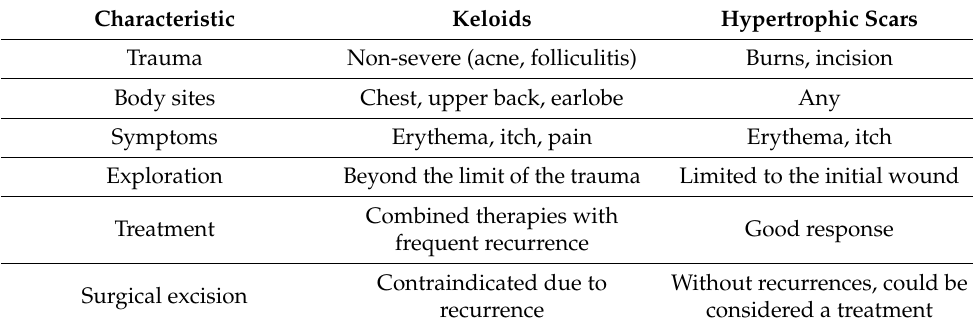
Table 1. Clinical differences between keloids and hypertrophic scars. Characteristic Keloids Hypertrophic Scars Trauma Non-severe (acne, folliculitis) Burns, incision Body sites Chest, upper back, earlobe Any Symptoms Erythema, itch, pain Erythema, itch Exploration Beyond the limit of the trauma Limited to the initial wound Combined therapies with Treatment Good response frequent recurrence Contraindicated due to Without recurrences, could be Surgical excision recurrence considered a